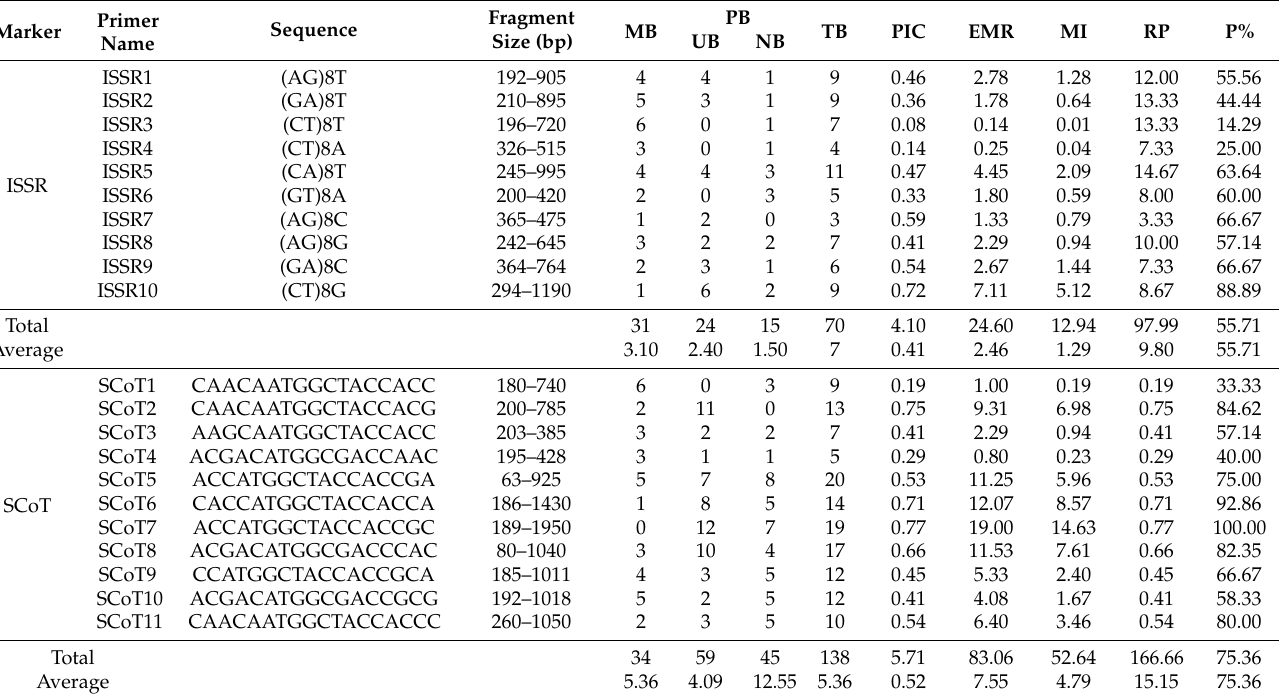
Table 2. Data generated from ISSR and SCoT markers for C. gileadensis accessions in KSA.